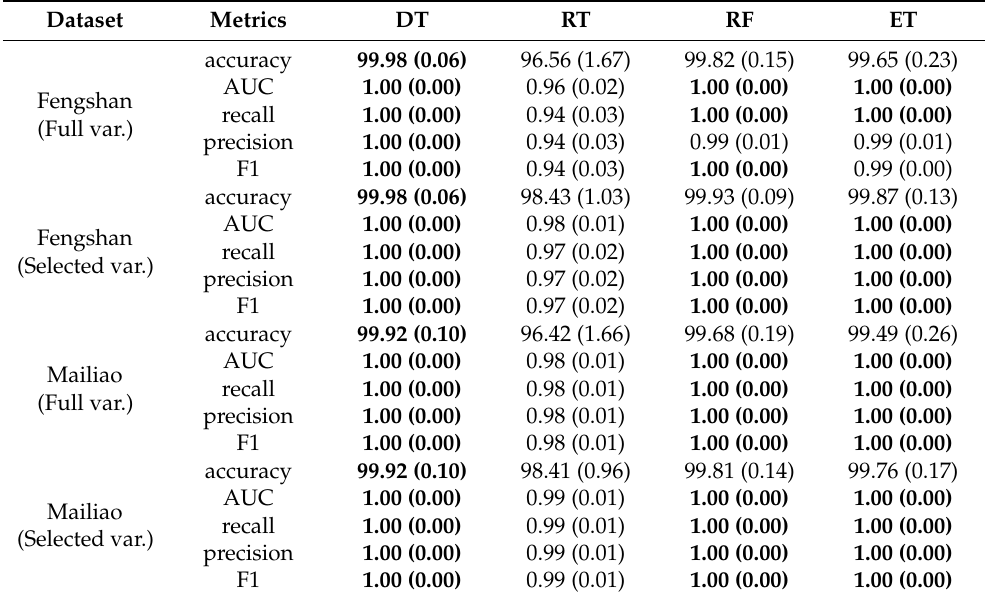
Table 5. Results of the four classifiers based on full and selected variables for the two datasets. Dataset